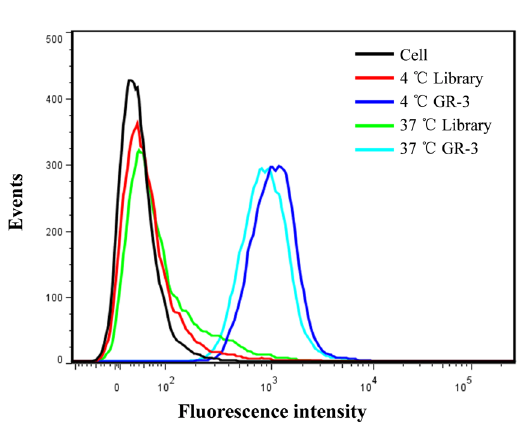
Figure 4. Target location and type analysis of aptamer GR-3. ( A ) Binding site of aptamer GR-3 to CHO-GCGR cells was investigated by confocal microscopy imaging. ( B ) CHO-GCGR cells were treated with trypsin or proteinase K and then incubated with FAM-labeled GR-3 to analyze the target type by flow cytometry. ( C ) Identification of binding affinity between biotin-labeled GR-3 and GCGR protein by aptamer-mediated pull- down assay.